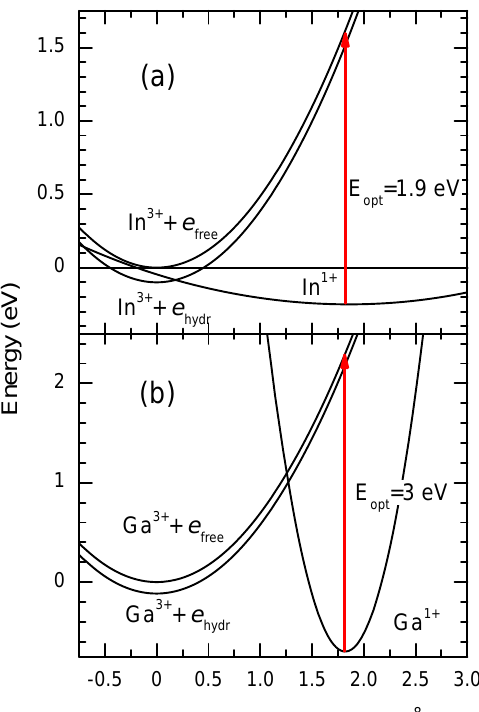
is a free carrier in the conduction free